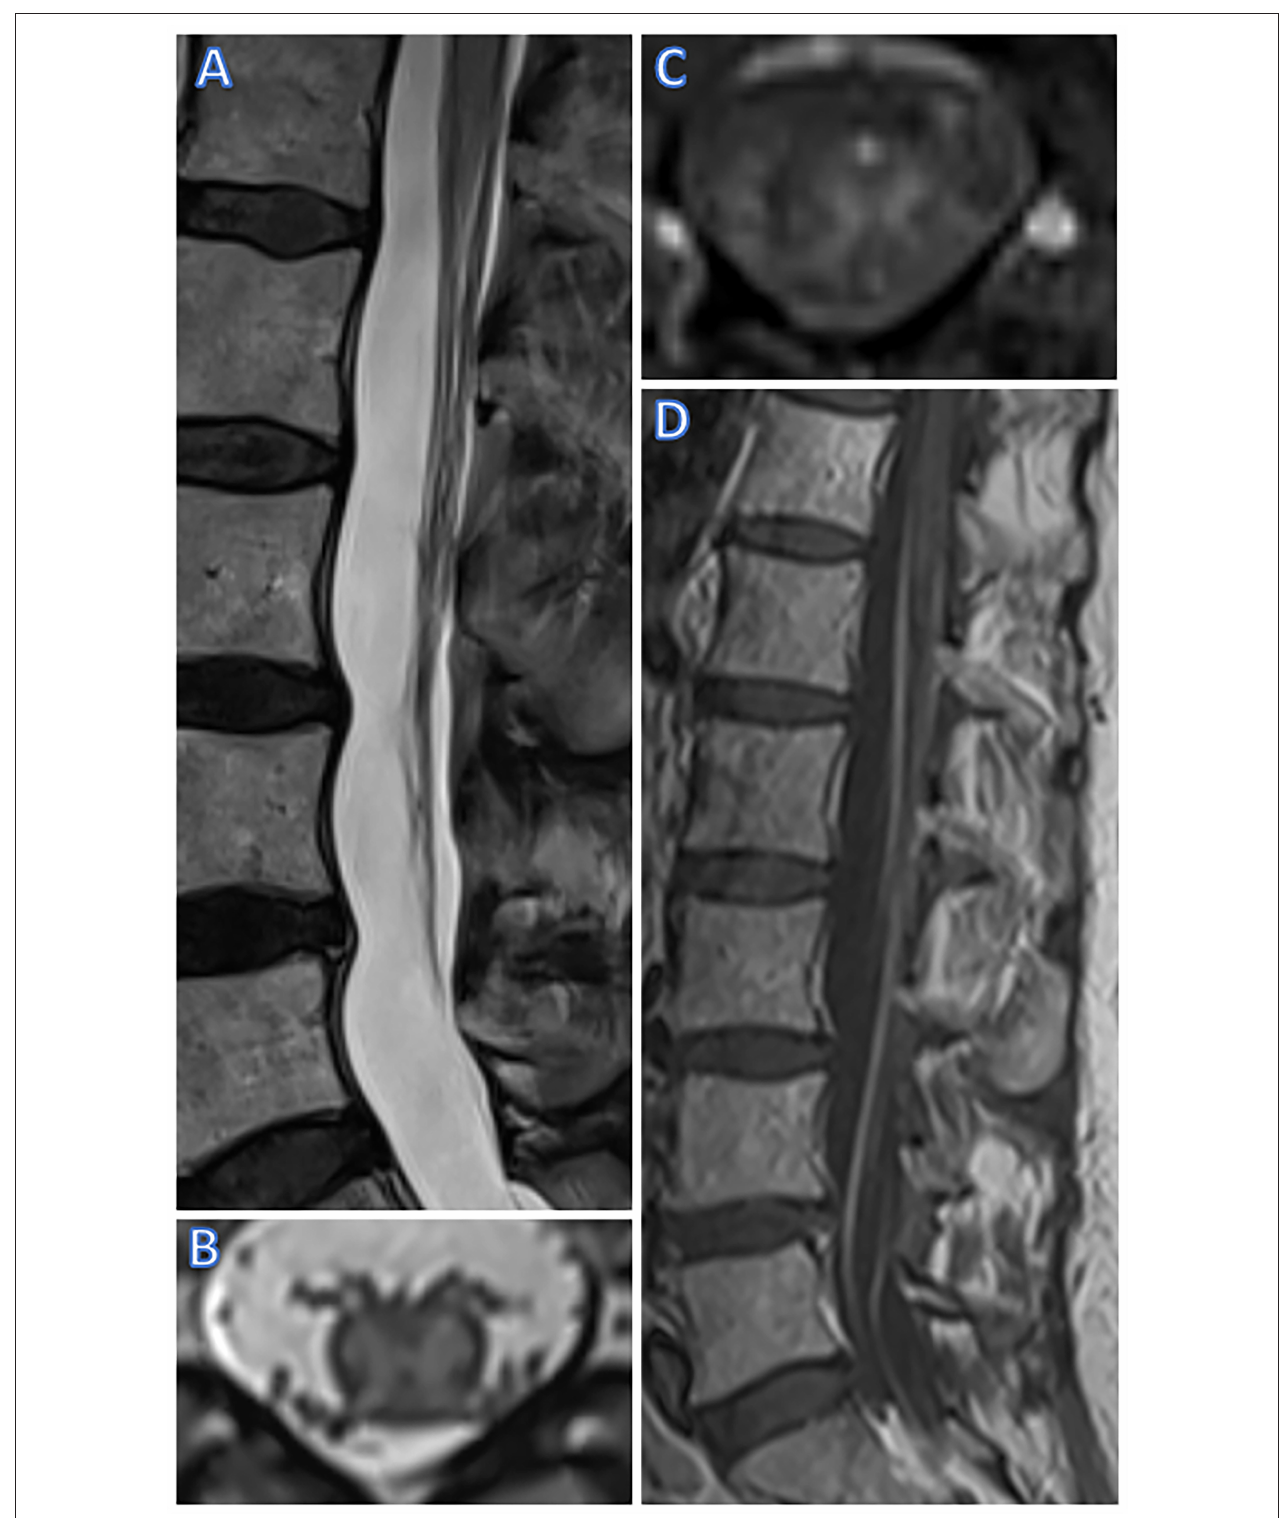
FIGURE 2 | MR Imaging of case 2 (female, 63 yrs). T2w sagittal imaging shows swelling and hyperintense lesions of the conus (A) while axial T2w imaging shows a butterfly-shaped lesion involving only the gray matter [at T11-12, (B) ]. T1w imaging showed discreet contrast enhancement of the anterior horns on axial imaging (C) , and, on day 22 after onset, post-contrast T1w imaging also showed contrast of spinal cord roots (D) .